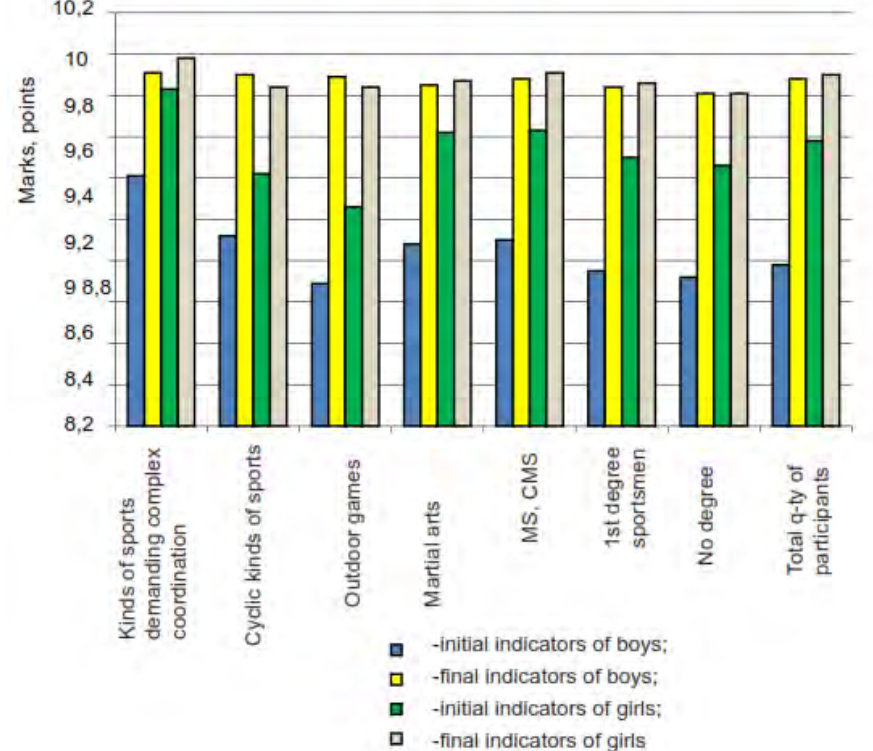
Fig. 13. Indicators, which characterize coordination abilities to execution of exercises for symmetric and asymmetric coordination by first year students of NU